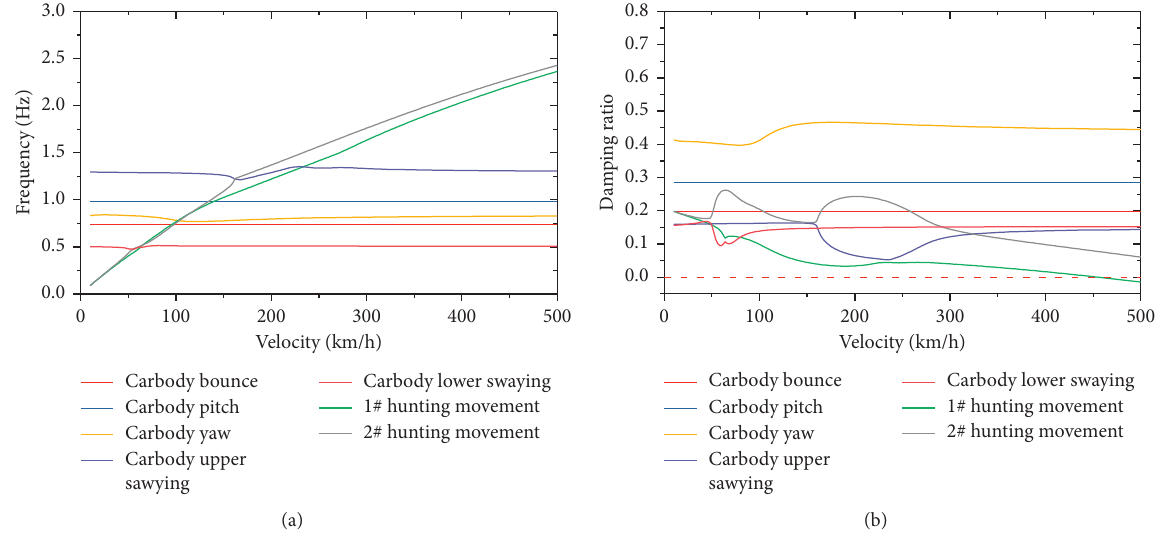
Figure 8: Analysis of eigenvalue on (a) frequency domain and (b) damping ratio.